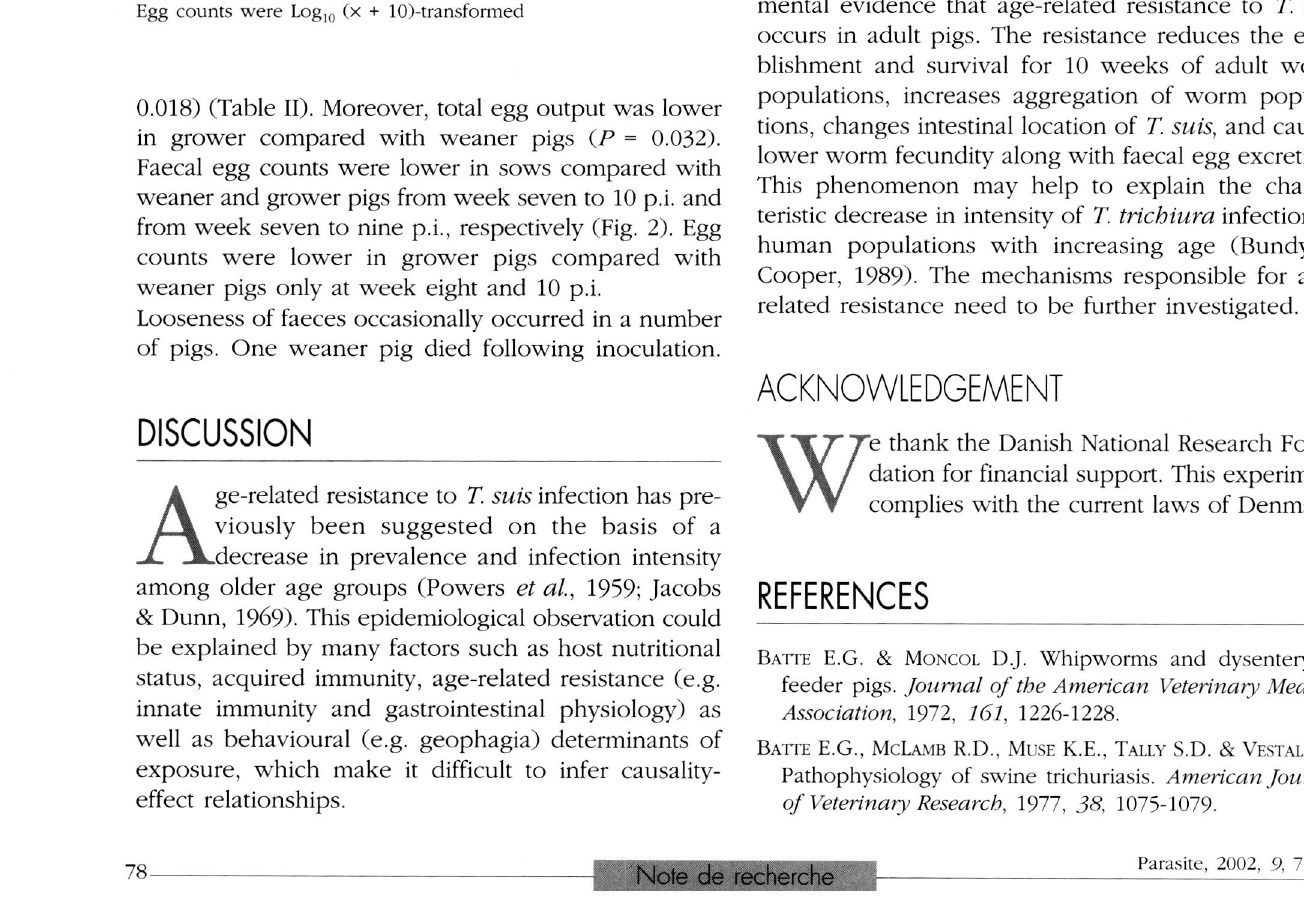
Fig. 2. - Geometric mean eggs per gram faeces (e.p.g.) from five to 10 weeks post infection in weaner pigs, grower pigs and sows infected with 3 x 50 eggs per kg body weight. Egg counts were Log (x + 1 10